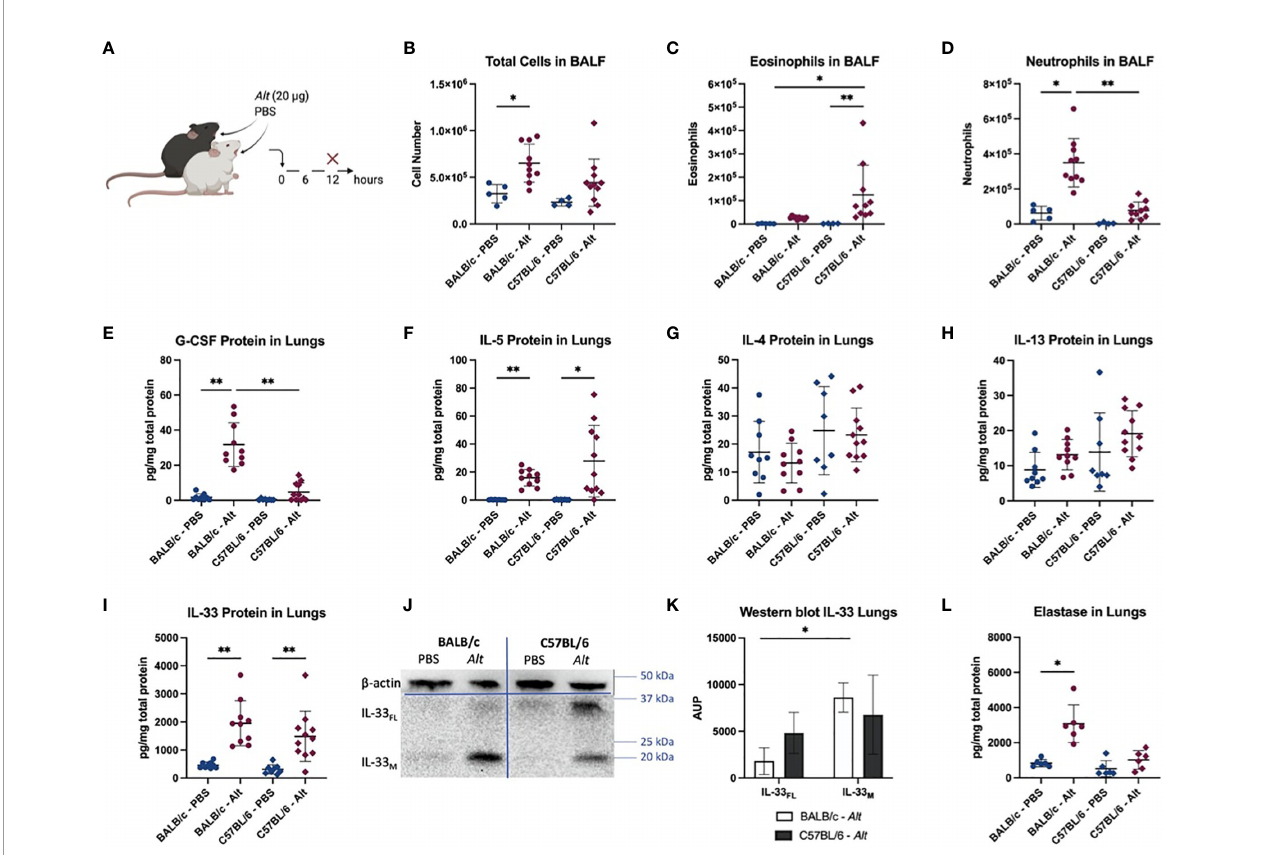
FIGURE 1 | Innate response to Alternaria alternata ( Alt) extract. BALB/c and C57BL/6 mice were given one intratracheal application of 20 µg Alt extract or PBS. Twelve hours after the application, the mice were euthanized, and samples were collected (A) . The total cell count (B) and eosinophils (C) and neutrophils (D) detected with fl ow cytometry in BALF are shown. The levels of G-CSF (E) , IL-5 (F) , IL-4 (G) , IL-13 (H) and IL-33 (I) were measured in the lung homogenates and with Luminex. Full-length IL-33 (IL-33 FL ) and cleaved, mature forms (IL-33 M ) were analyzed by western blotting and one representative blot is shown (J) . The area under the peak (A.U.P.) was quanti fi ed using ImageJ software (K) . n=4-11. The levels of elastase protein in lung homogenates is shown in (L) . Data is presented as mean ± SD, *P < 0.0332; **P <